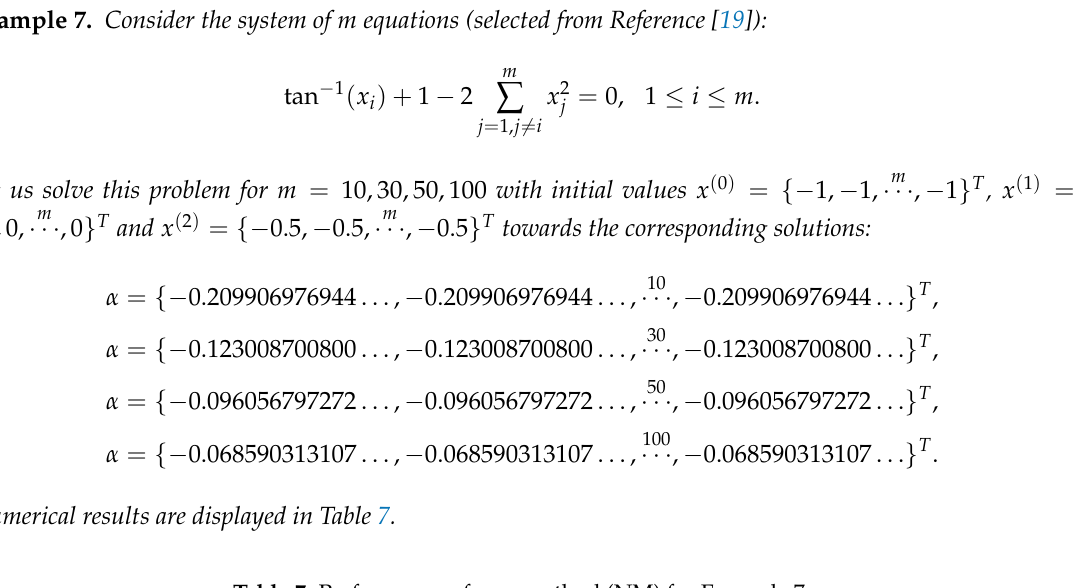
Table 7. Performance of new method (NM) for Example